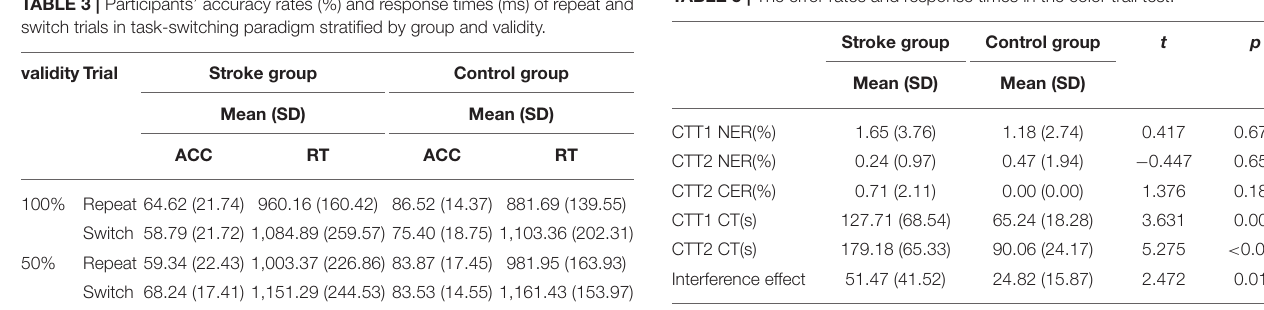
Table 7 . In the task-switching paradigm, the stroke group showed